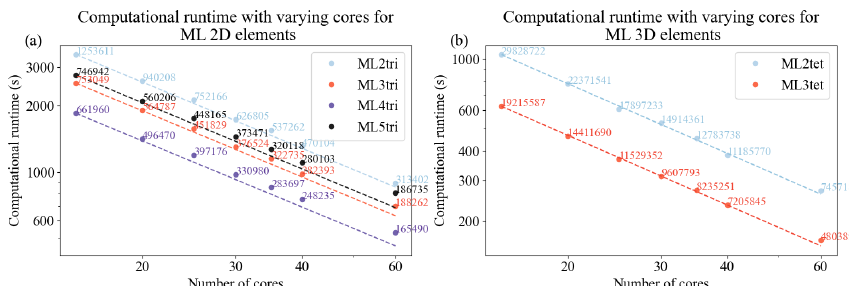
Figure 14. Strong scaling curves for solving the acoustic wave equation with a PML in spyro for 2D (a) and 3D (b) cases given a range of computational resources using Intel nodes. The dashed lines represent ideal scaling for each element, and the average number of degrees of freedom per core is annotated.